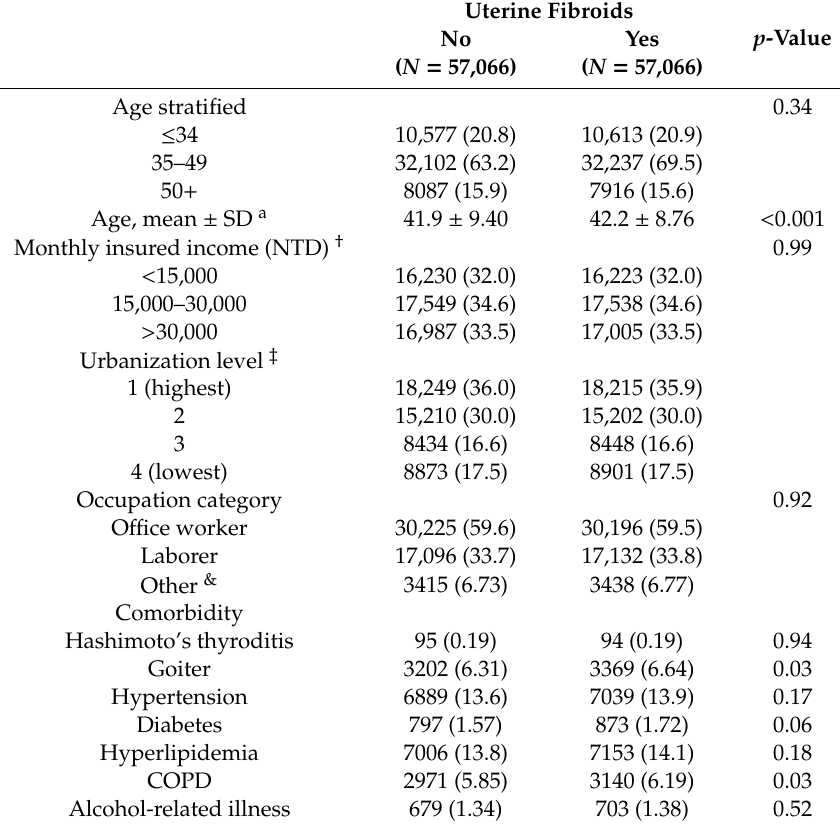
Table 1. Characteristics of demography and comorbidities distribution for patients with and without uterine fibroids.